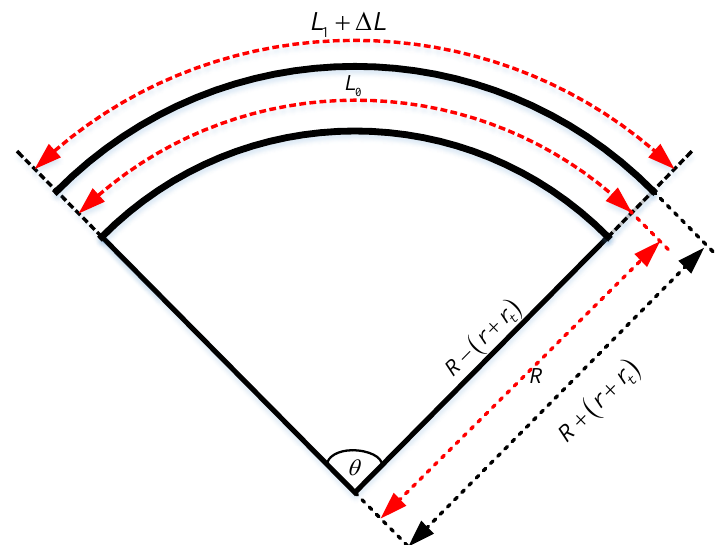
Figure 2. Diagram of the bending of the soft arm.